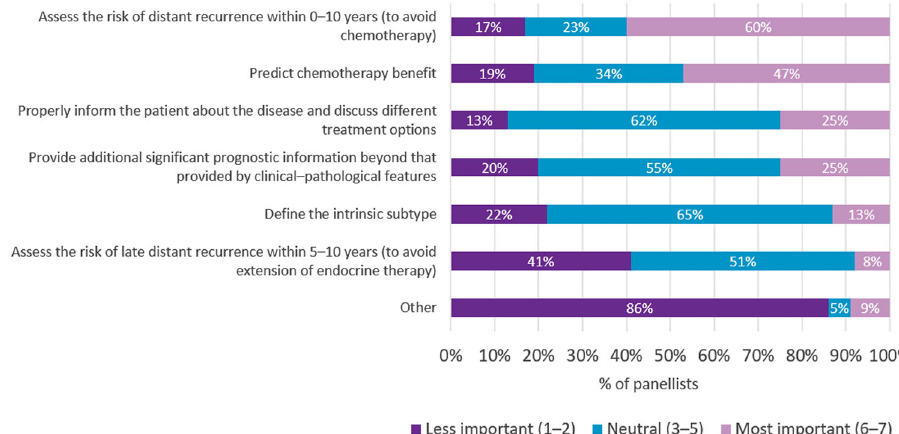
Fig. 1 Reasons for use of breast cancer multigene signatures in patients with early-stage breast cancer. Percentage of panellists ranking the importance of reasons for using BCMS from least important (1) to most important